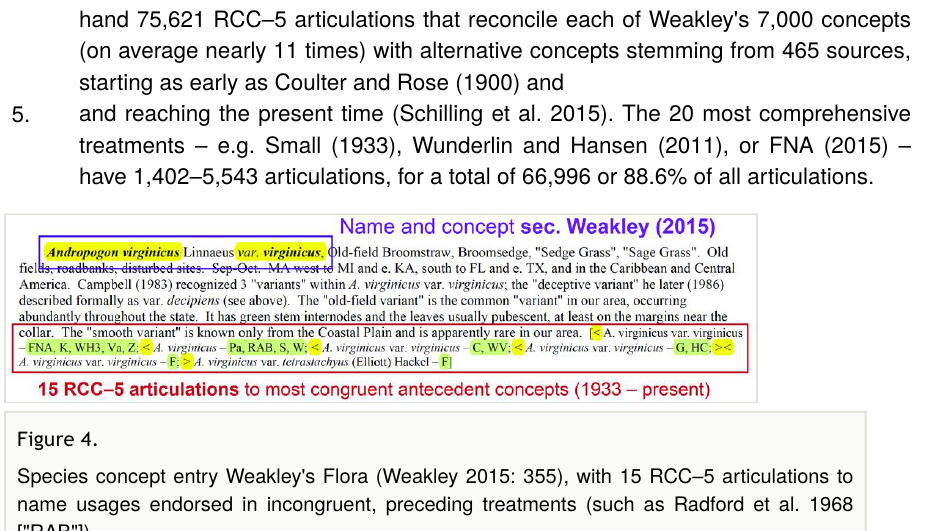
Species concept entry Weakley's Flora (Weakley 2015: 355), with 15 RCC–5 articulations to name usages endorsed in incongruent, preceding treatments (such as Radford et al.